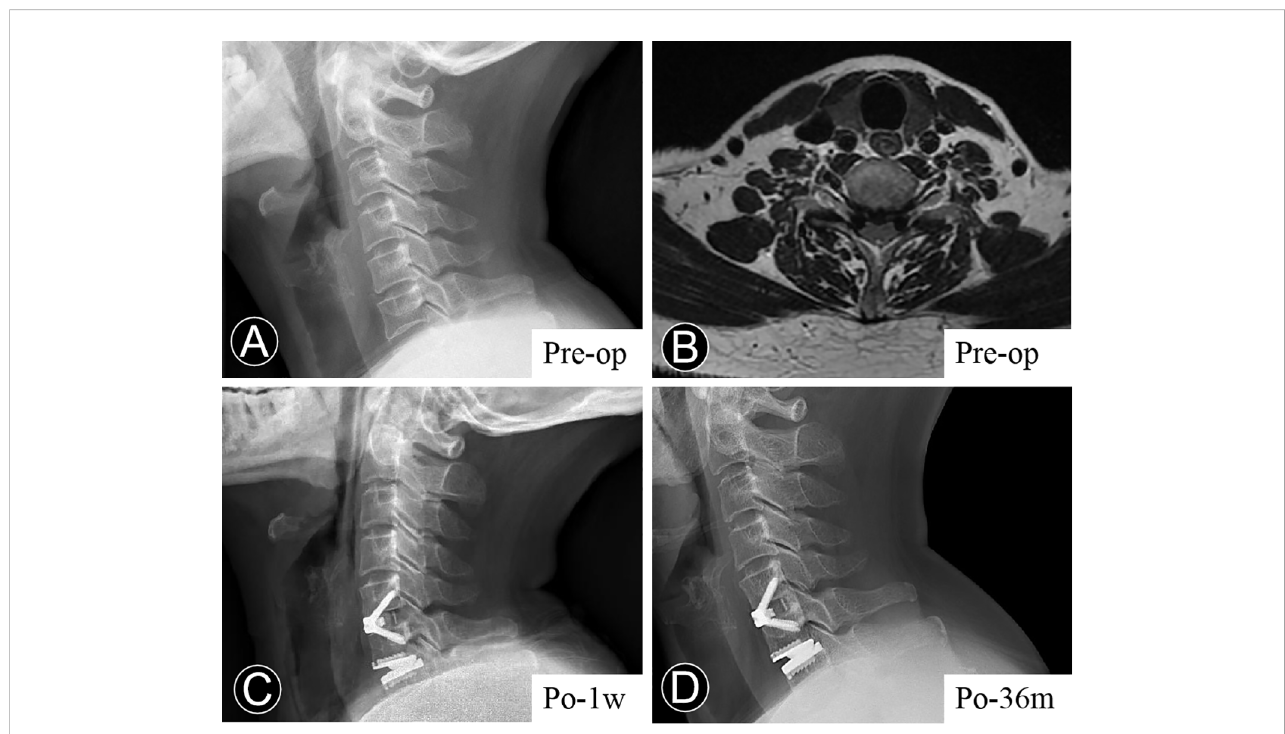
FIGURE 4 Representative case. Serial radiological examinations of a 67-year older woman with neck pain for more than two years. (A) Lateral view, showing that the preoperative cervical lordosis was 4.78°, and C2-7 sagittal vertical axis 4.01 cm. (B) T2-weighted axial MRI section, presenting a fatty in fi ltration degree of Goutalier 3-4. (C) The immediate postoperative lateral radiograph demonstrated a relatively satisfactory sagittal alignment. (D) At the last follow-up, the lateral radiograph demonstrated the loss of cervical lordosis and an increase in the sagittal vertical